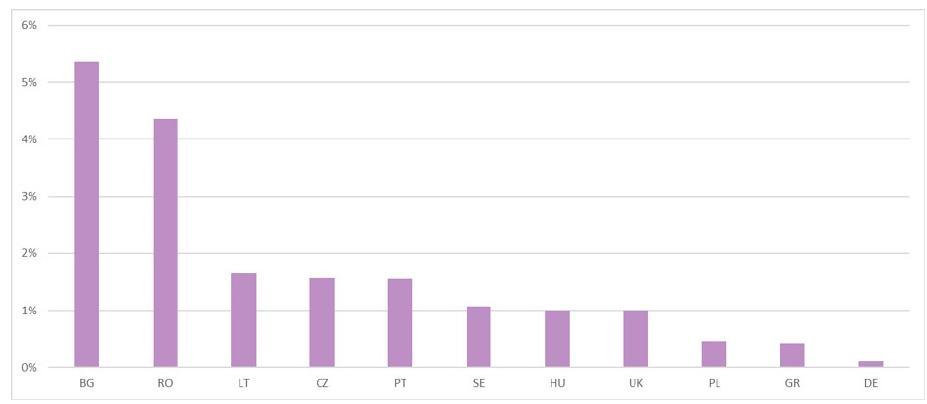
Figure 7. Total CLLD funding (EUR) vs. CLLD share of eligible ESI funding by country, 2014–2020 [7]. Note—a logarithmic scale is used on the y-axis . The overall share of CLLD by Member State was relatively evenly spread between 0.8% in Malta and 5.2% in Luxembourg. However, four countries stand out in terms of